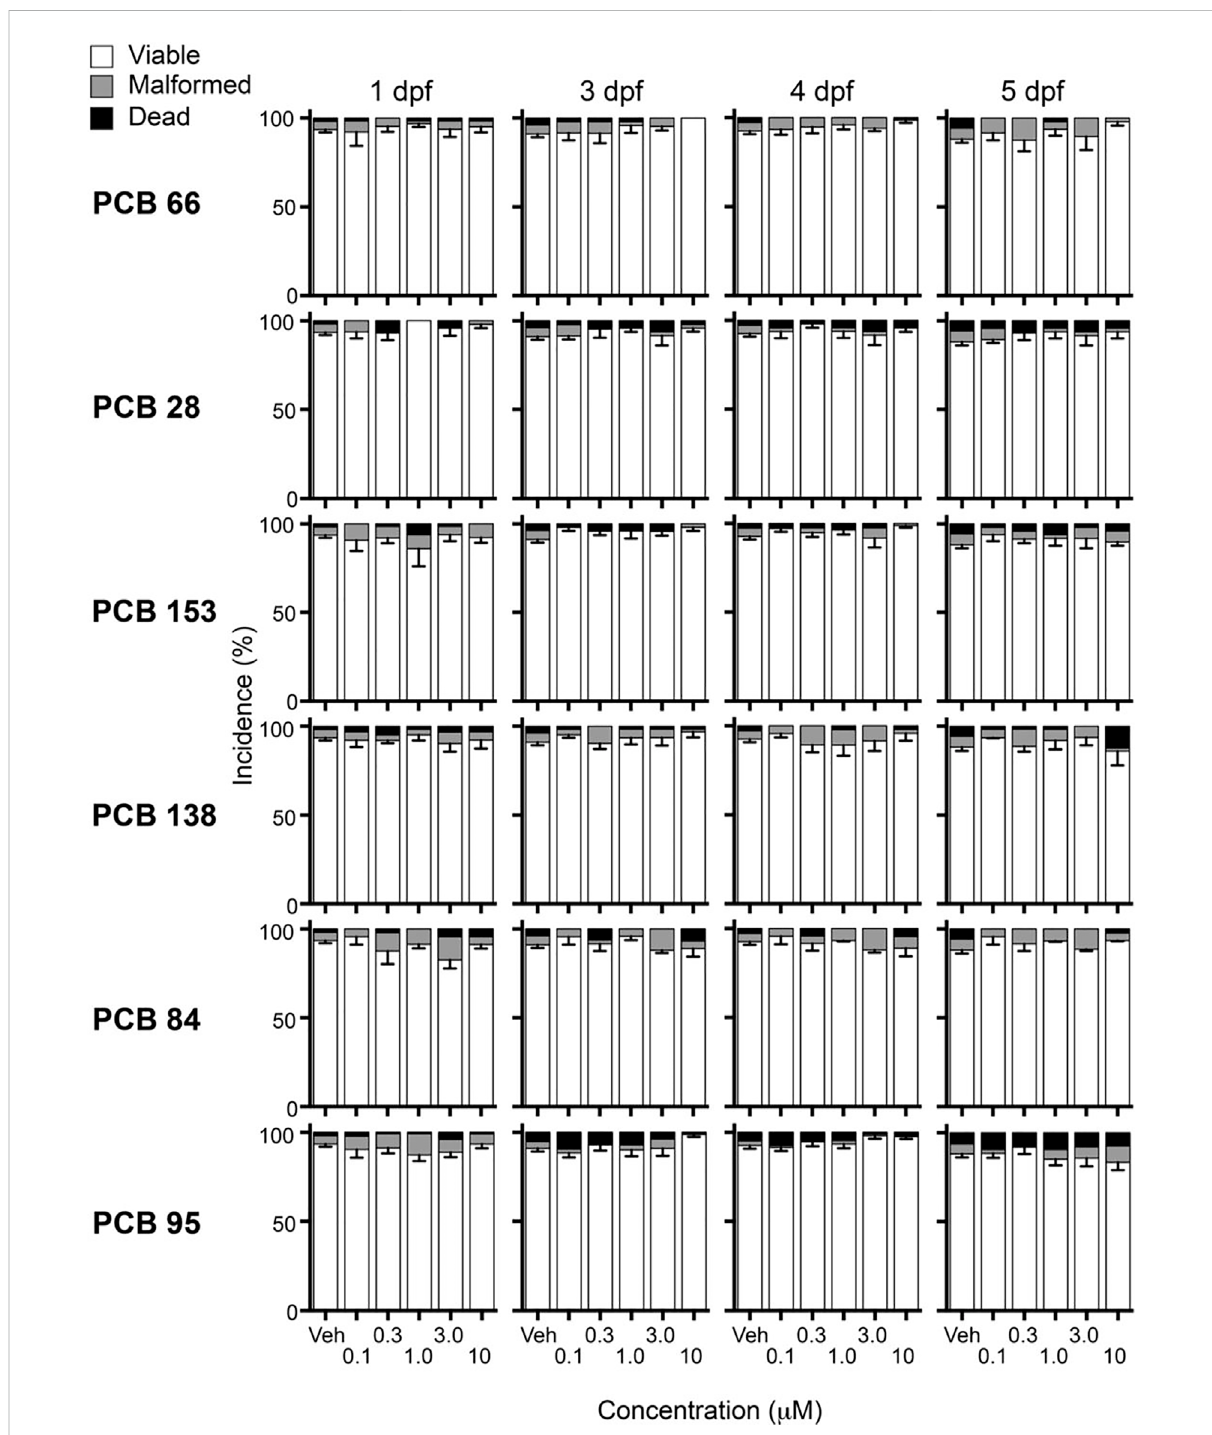
FIGURE 2 PCB exposures did not signi fi cantly decrease viability (congeners listed in order of increasing RYR binding af fi nity). Larvae were observed for overt malformations or mortalities at 1, 3, 4, and 5 days post-fertilization (dpf). Data are presented as mean percentage (malformed and dead) or mean percentage (viable) ± SEM from ≥ 3 separate spawns. The total larvae per exposure (Vehicle (Veh), 0.1, 0.3, 1.0, 3.0, and 10 µM) was the following: PCB66:32, 60,61,63,60,and60;PCB28: 23,45,44, 48, 48,and47;PCB 153:28,58,58,58, 60,and60;PCB 138:28, 59,61,63,59, and 59; PCB 84: 32, 56, 56, 57, 52, and 57; PCB 95: 61, 85, 115, 111, 113, and